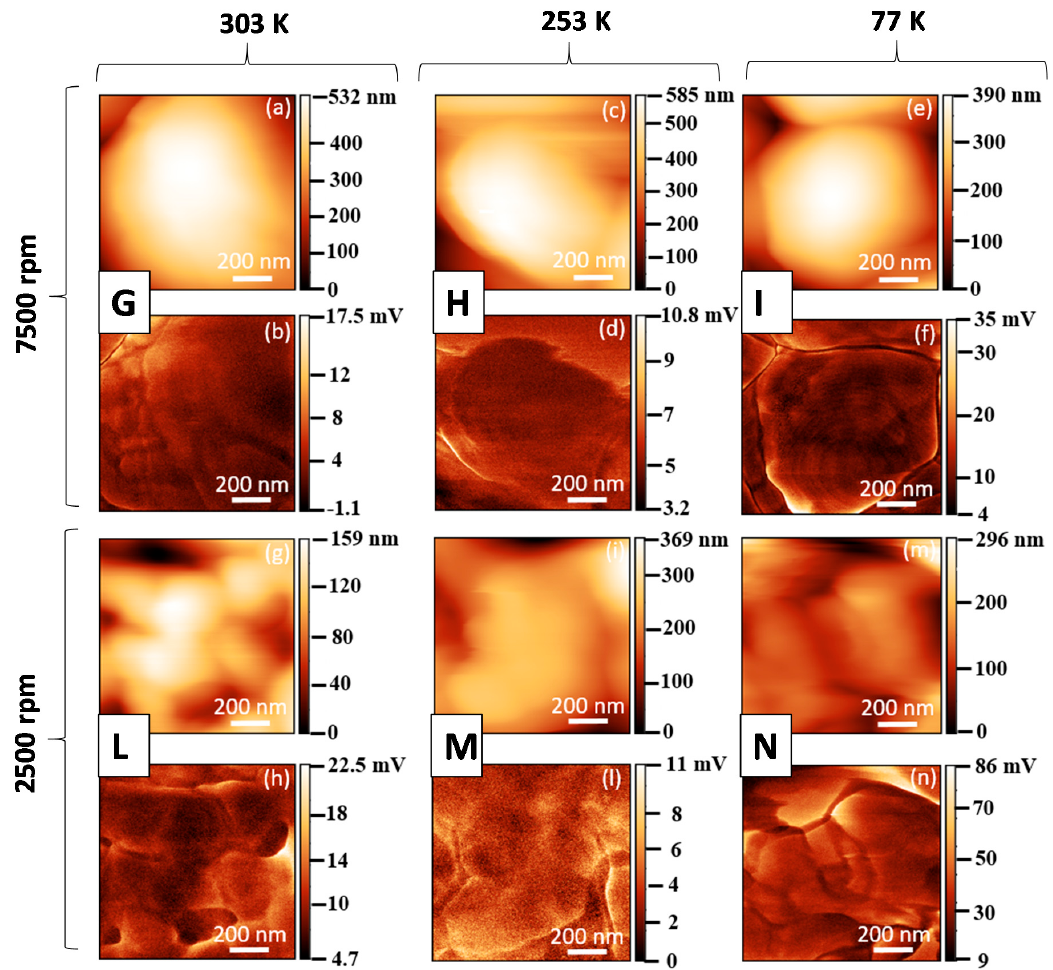
Figure 6. Morphological maps and PFM signals at V ac = 10 V and at 15 kHz for PVDF at 30 wt.% produced at different temperatures and spinning speeds: ( a , b ) Sample G, ( c , d ) sample H, ( e , f ) sample I, ( g , h ) sample L, ( i , l ) sample M, ( m , n ) sample N.